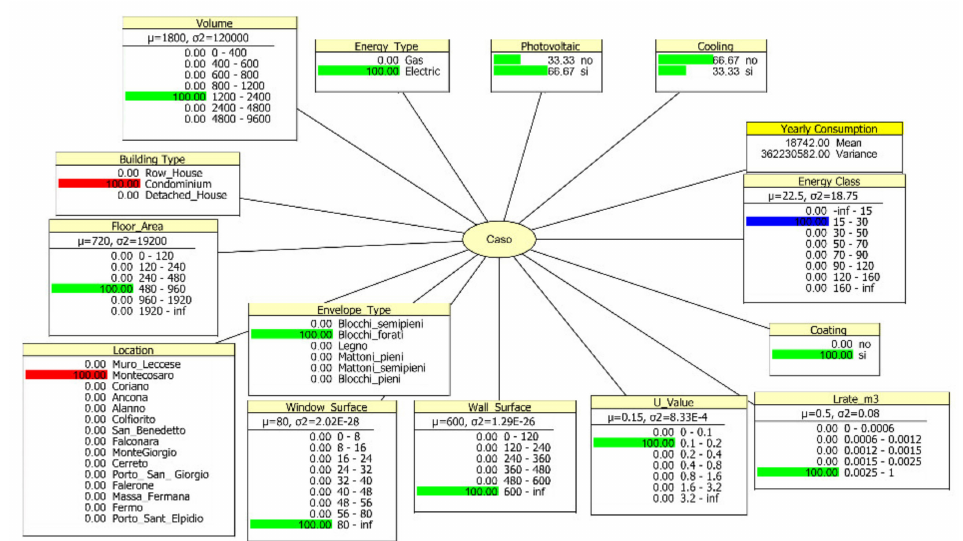
Figure 20. The effect of a PV installation in a case located in the municipality of Montecosaro.